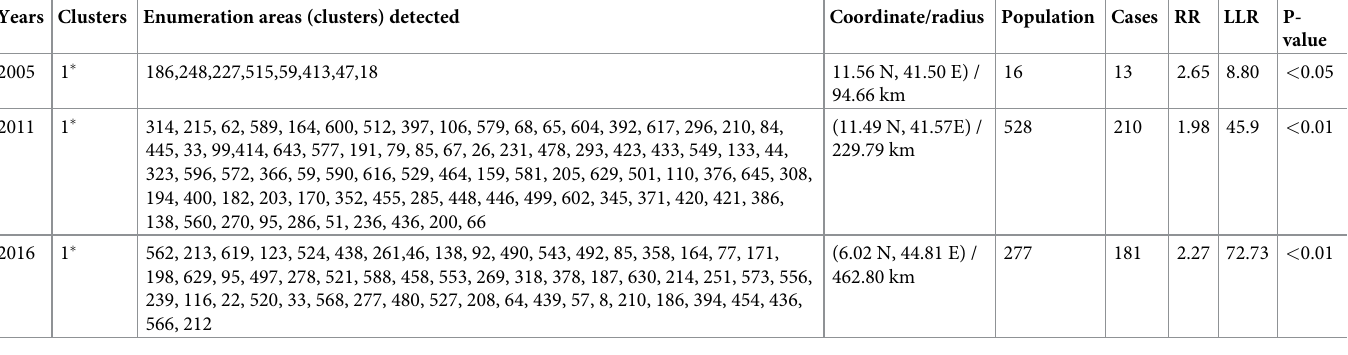
Table 3. Significant spatial clusters of anemia among lactating mothers in Ethiopia, EDHS 2005, 2011, 2016. Years Clusters Enumeration areas (clusters)